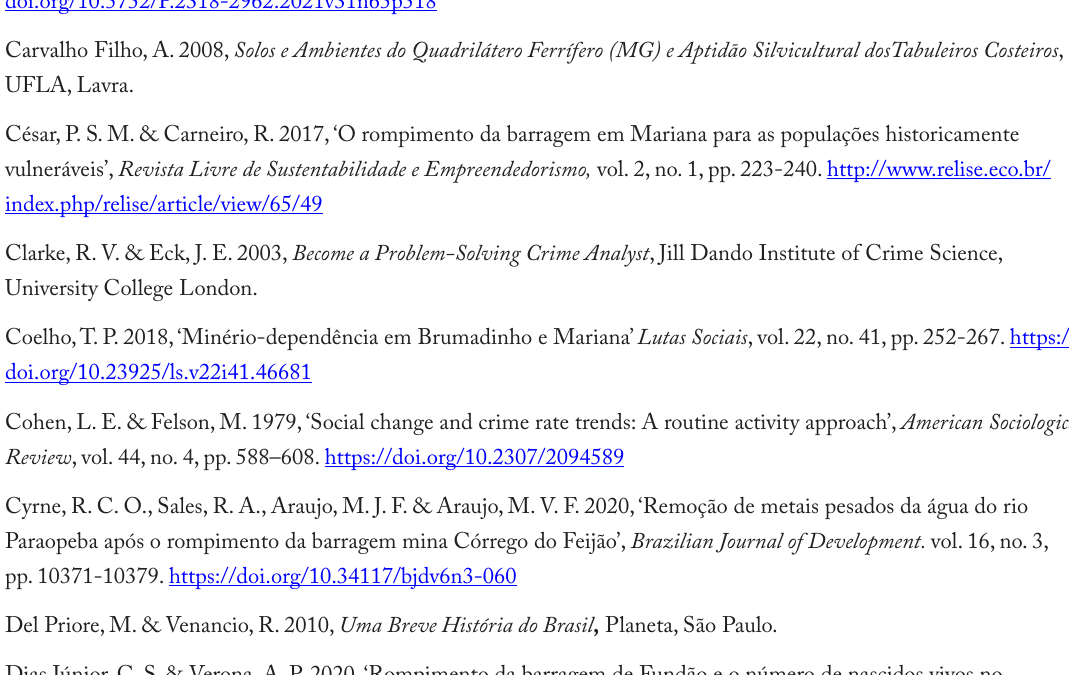
Figueira, M. 2016, ‘Espaços urbanos seguros: teorias, abordagens e metodologias’, In: Convivência e segurança cidadã : reflexões por uma nova abordagem de segurança pública . UNDP, Brasilia, pp. 129-134. Fontes, R. N. & Lopes, I. S. 2017, ‘As representações da mídia sobre o rompimento da barragem do Fundão em